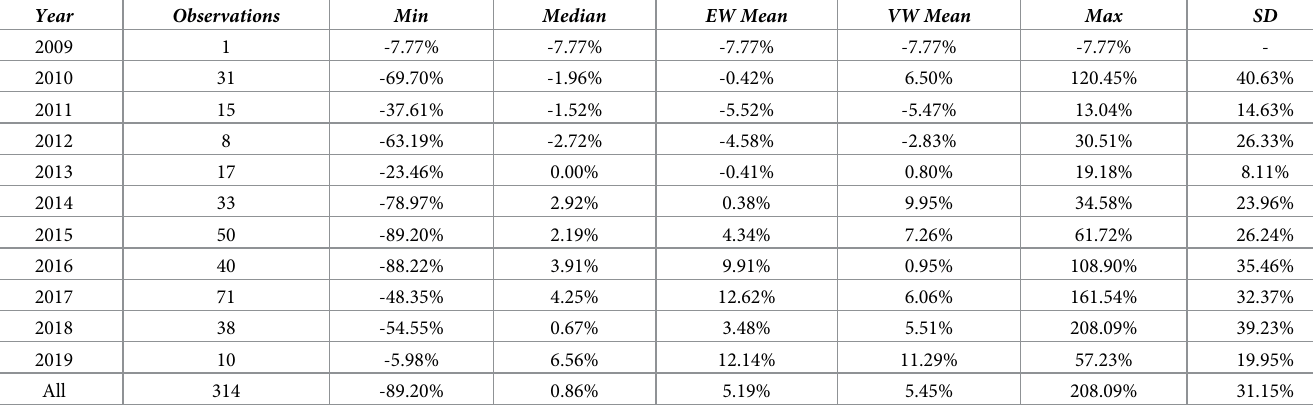
Table 1. Descriptive statistics of first-day returns on the issuing firms’ securities.